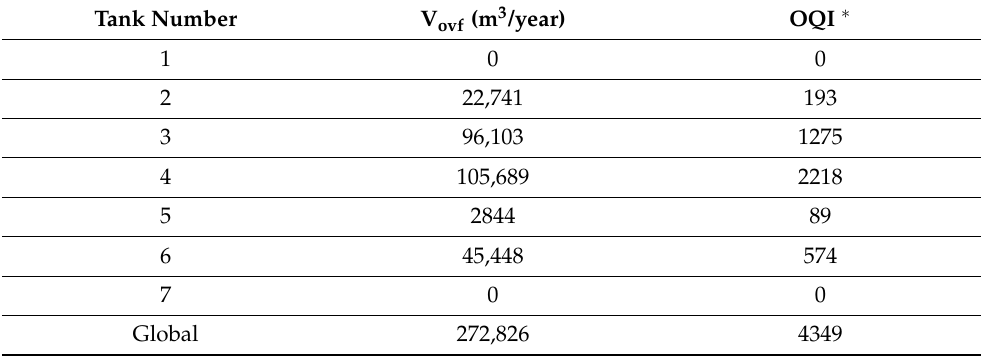
Table 16. Simulation results when the overflow quality index is minimized (strategy #5).